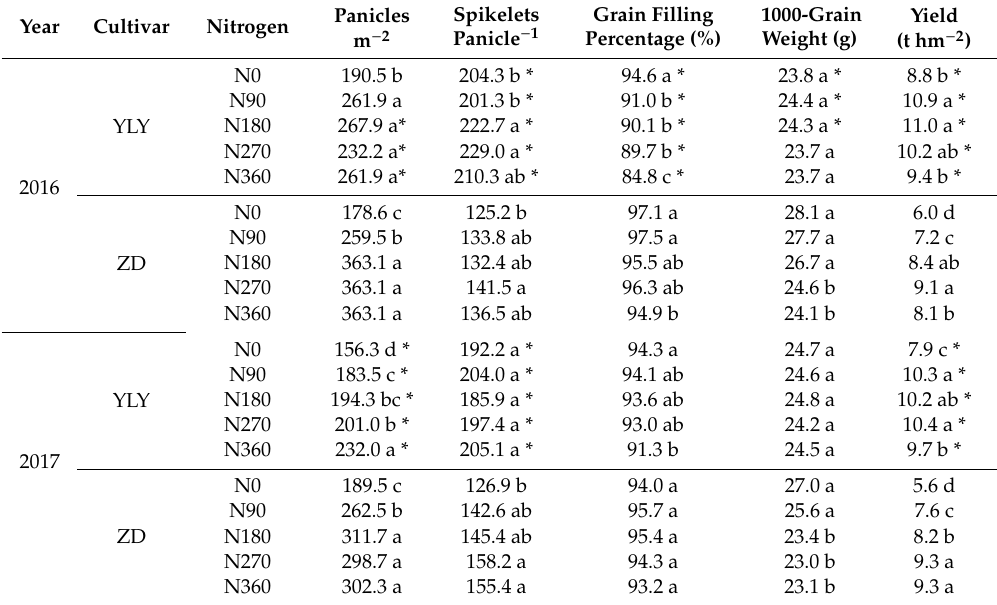
Table 1. Yield and yield components for YLY and ZD under di ff erent nitrogen (N) treatments at Rugao County, Jiangsu Province, China in 2016 and